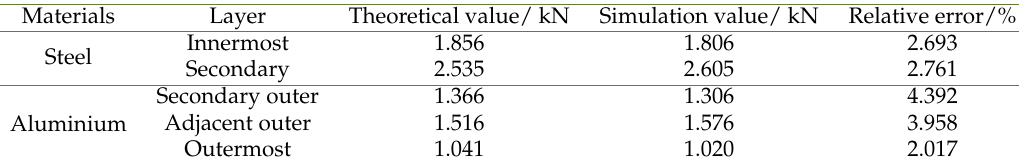
Fig. 6. Finite element model and mesh generation of positive feeder Table 3. Axial tension of strands in each layer of positive